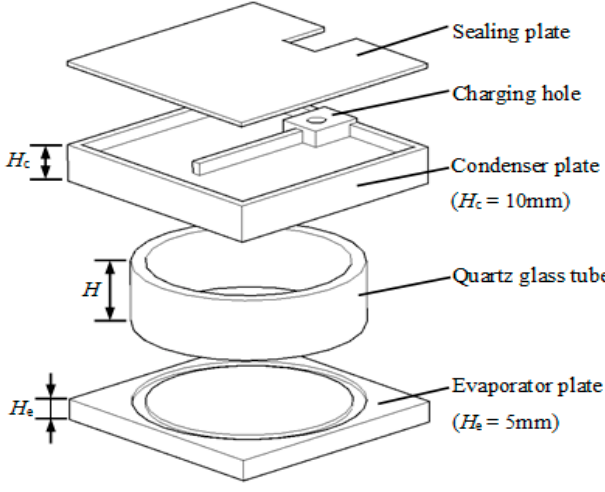
Figure 2. Schematic of the flat two-phase thermosyphon.